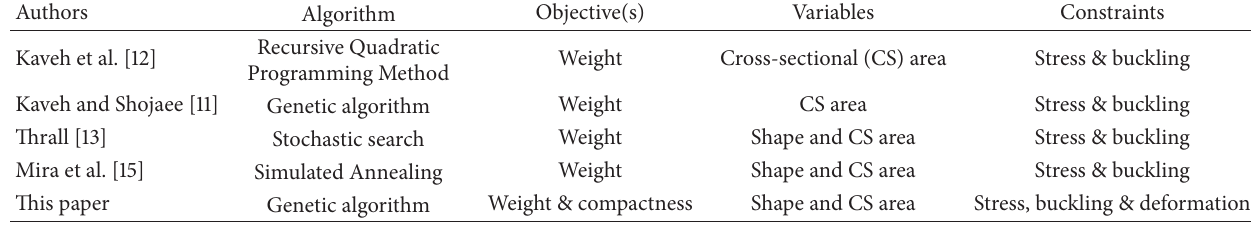
Table 1: Comparison of current research with previous researches on optimisation of scissors structures.